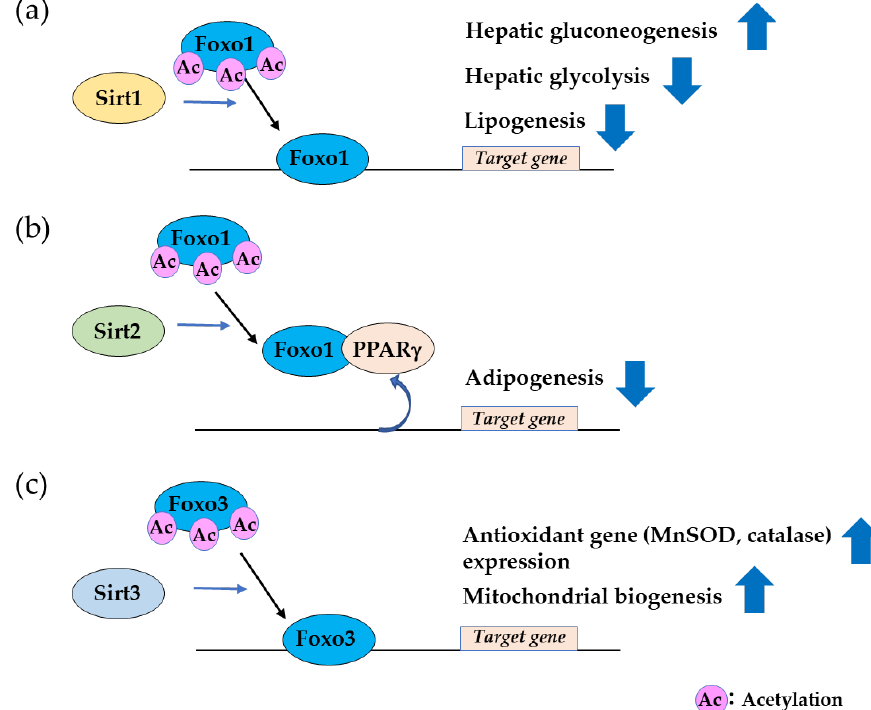
Figure 3. Sirtuin regulation of forkhead box (FOXO) in gluconeogenesis, adipogenesis, mitochondrial biogenesis and the antioxidant reaction. ( a ) Sirt1 binds and deacetylates Foxo1, leading to Foxo1 transactivation and induction of hepatic gluconeogenesis. ( b ) Sirt2 deacetylation of Foxo1 promotes binding to PPAR γ , suppressing PPAR γ activity and adipogenesis. ( c ) Sirt3 deacetylation of Foxo1 induces mitochondrial biogenesis and protects cells from oxidative stress.